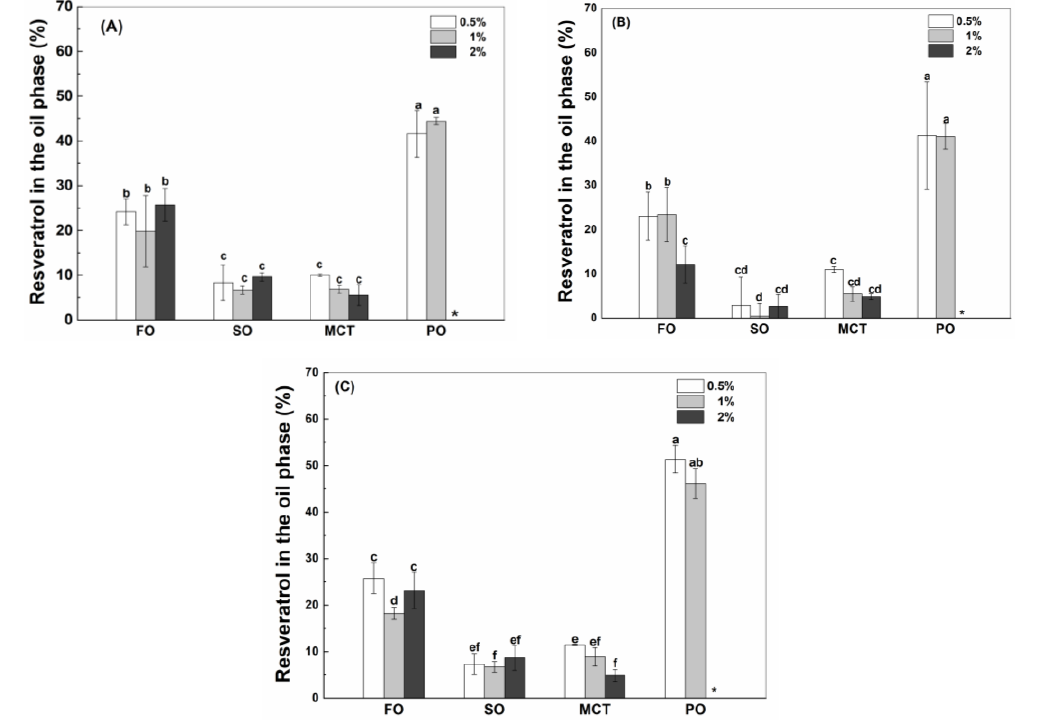
Figure 6. Percentage of resveratrol in the oil phase of fish oil (FO), sunflower oil (SO), MCT and peppermint oil (PO) emulsions stabilized by native WPI ( A ), heat-denatured WPI ( B ) and sodium caseinate ( C ) at 0.5%, 1% and 2%. Different letters mean significant differences at p < 0.05. * Peppermint oil emulsions were unstable at 2% proteins.